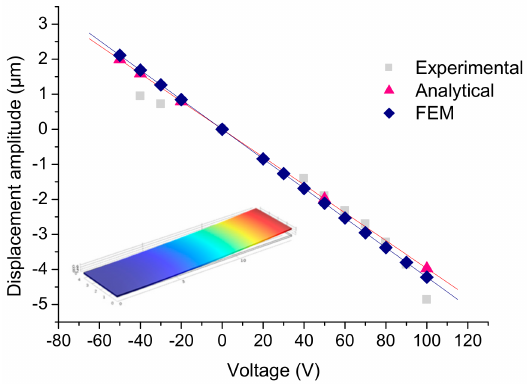
Figure 3. Concordance between experimental measurements and models responses in terms of maximal displacement as a function of applied voltage, on a cantilever